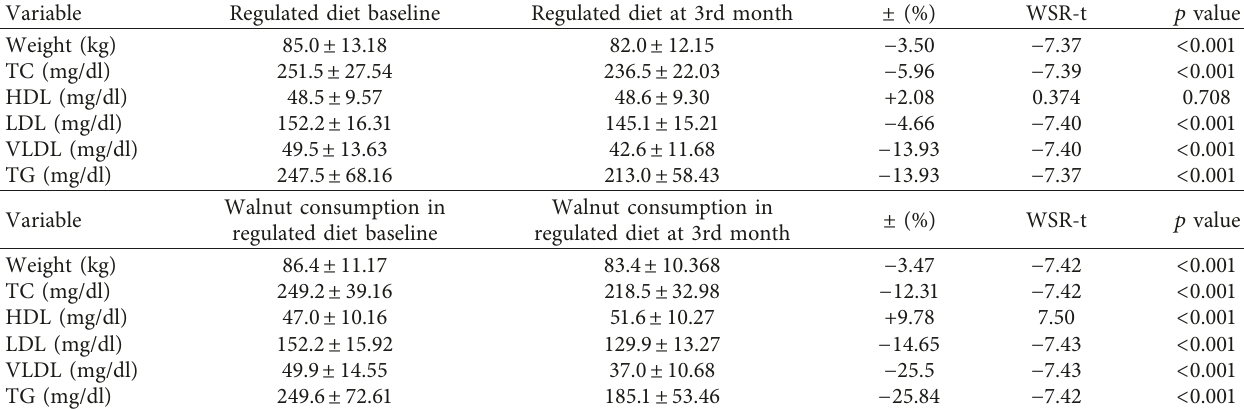
Table 2: The comparison of baseline and at 3rd month values for both groups.